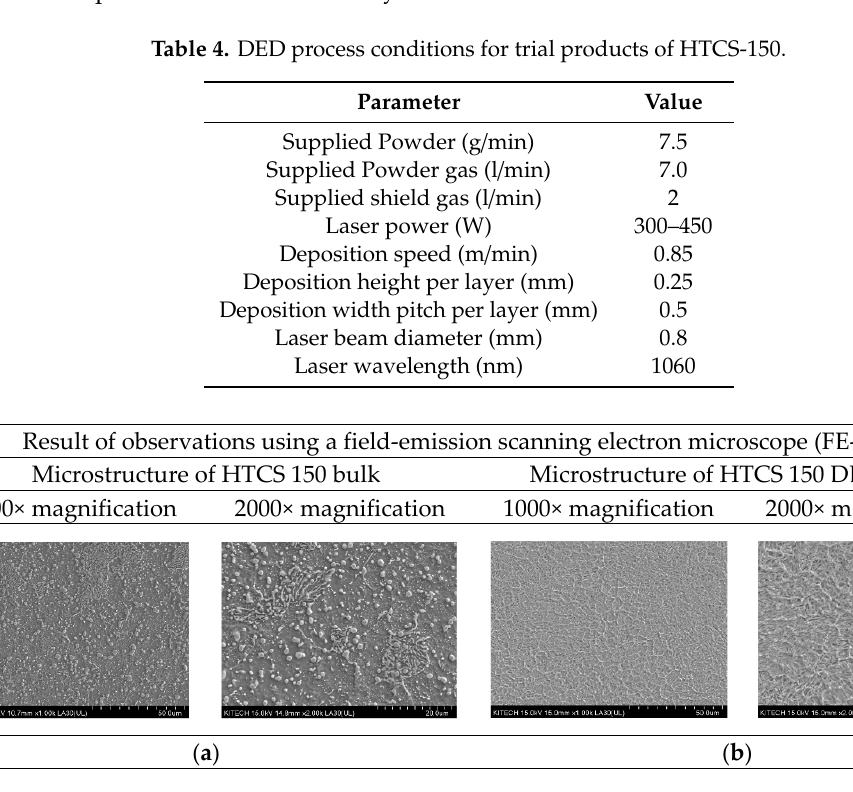
Figure 3. Analysis results of the microstructures of the HTCS-150 bulk and the specimen made by the AM process ( a ) microstructure of the HTCS-150 bulk material ( b ) microstructure of the HTCS-150 AM material. Table 5. Thermal conductivity and surface hardness of HTCS-150 without heat